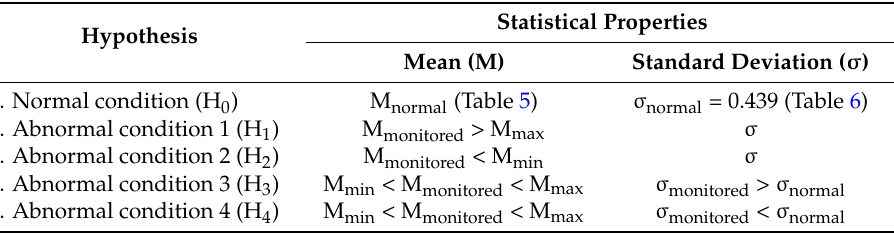
Table 1. Hypotheses for